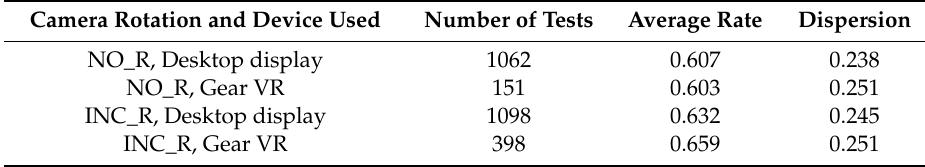
Table A13. Numerical results of the users regarding the camera rotation and device used. Camera Rotation and Device Used